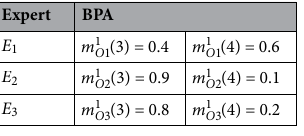
Table 2. Evaluation information by three